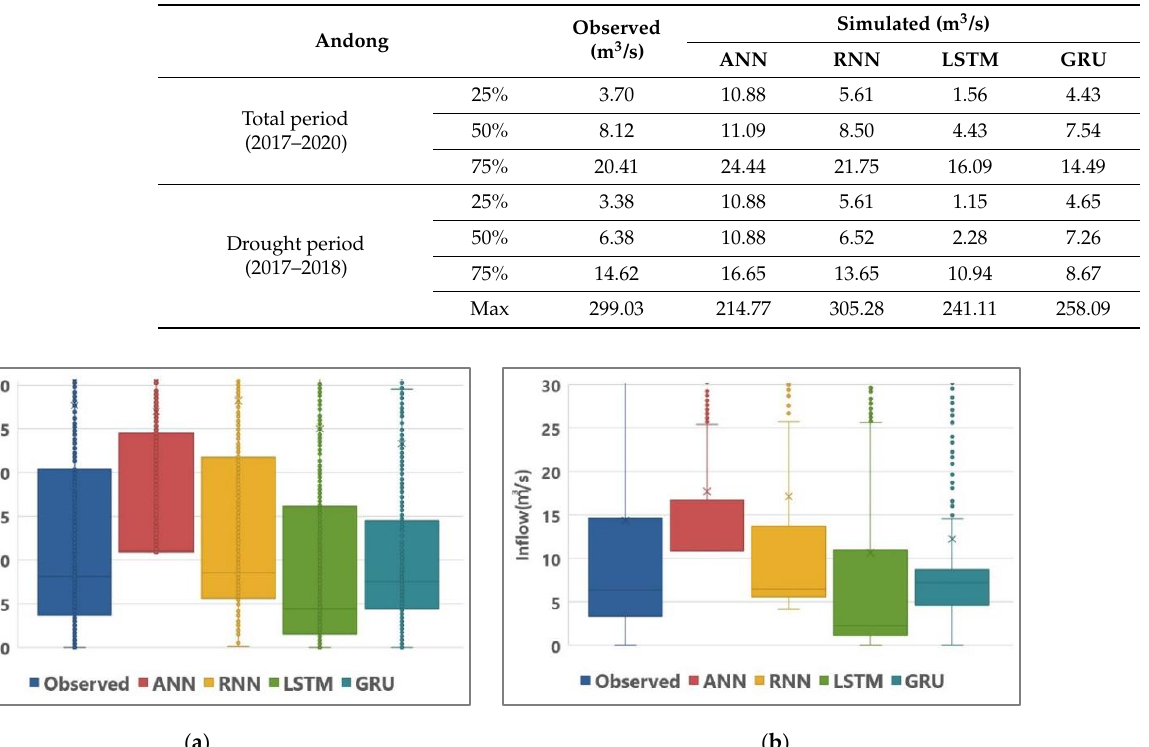
Figure 7. Comparison of predictions and observations for inflow ranges to Andong Dam. ( a ) Total period. ( b ) Drought period. Table 7. Inflow prediction by period at Andong Dam.